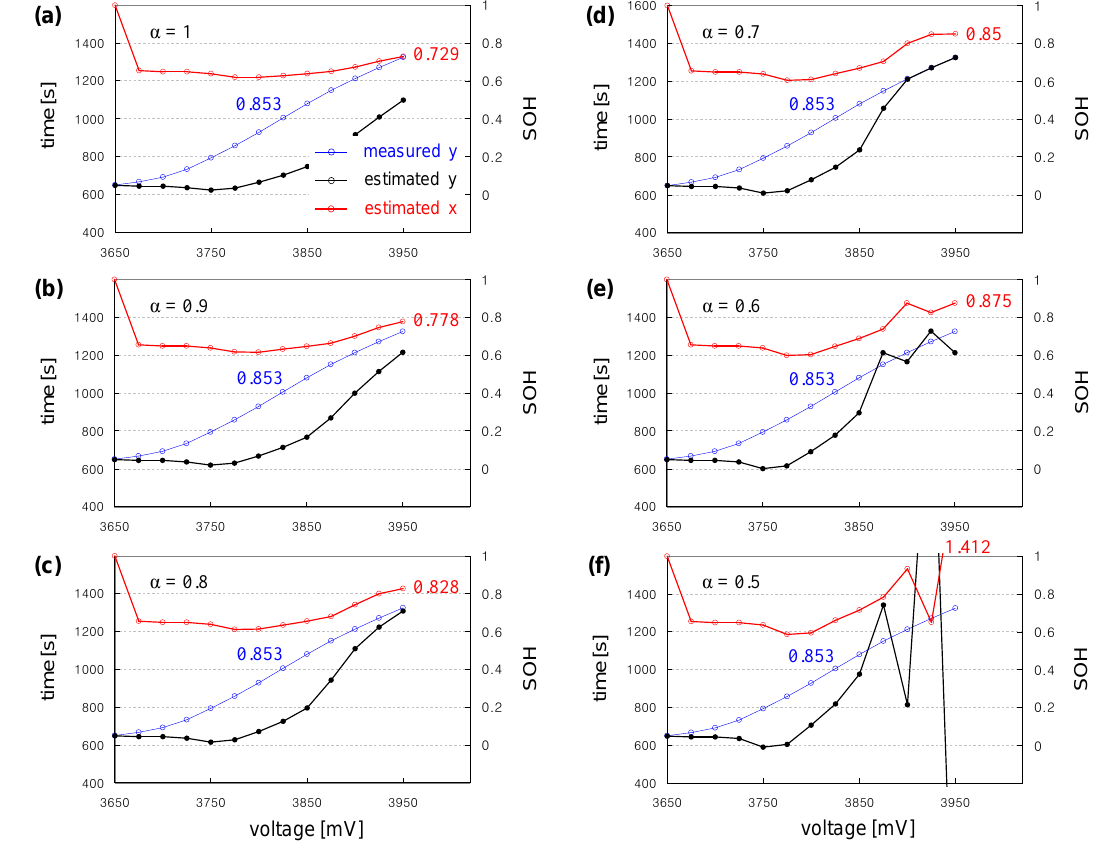
Figure 6. E ff ect of forgetting factor α on tracking and convergence performance of RLS. The forgetting factors α to be compared are ( a ) 1, ( b ) 0.9, ( c ) 0.8, ( d ) 0.7, ( e ) 0.6, and ( f ) 0.5. The test data is obtained from the battery pack at 85.3%